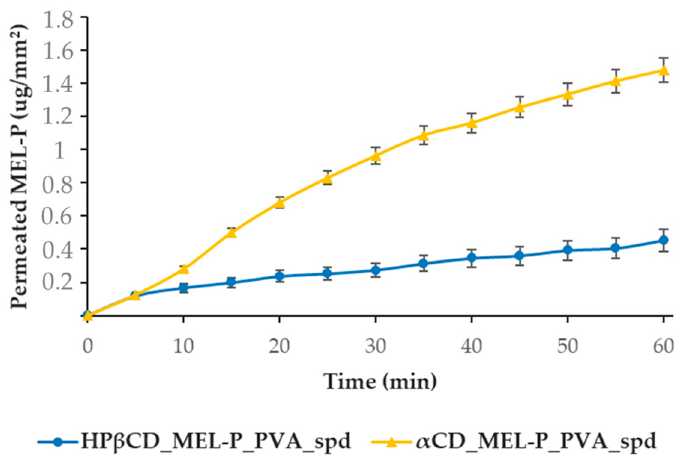
Figure 9. Ex vivo permeability study of HP β CD_MEL-P_PVA_spd and α CD_MEL-P_PVA_spd on human nasal mucosa.